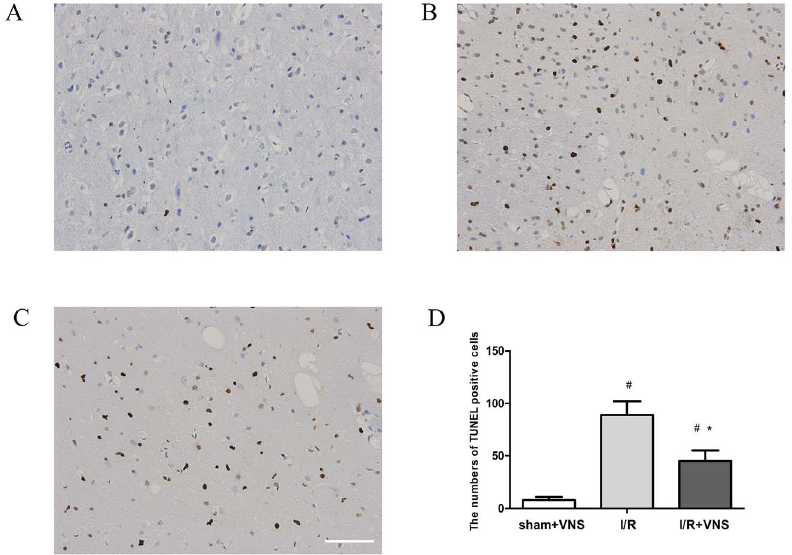
Figure 7. Effect of VNS on neuronal apoptosis in ischemic penumbra. Representative photomicrographs of neuron apoptosis in right ischemic penumbra cortex 24 h after reperfusion (magnification 400 6 ). A: sham + VNS group, B: I/R group, C: I/R + VNS group. D: Quantitative analysis of the number of TUNEL-positive cells in the ischemic penumbra. Data are expressed as mean 6 SEM; * P , 0.05 vs I/R group, # p , 0.05 vs sham + VNS group, scar=100 m m.